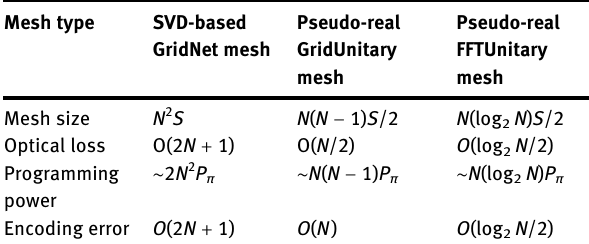
Table  : PerformancecomparisonamongSVD-basedGridNetmesh, pseudo-real GridUnitary mesh and pseudo-real FFTUnitary mesh for PNN applications.